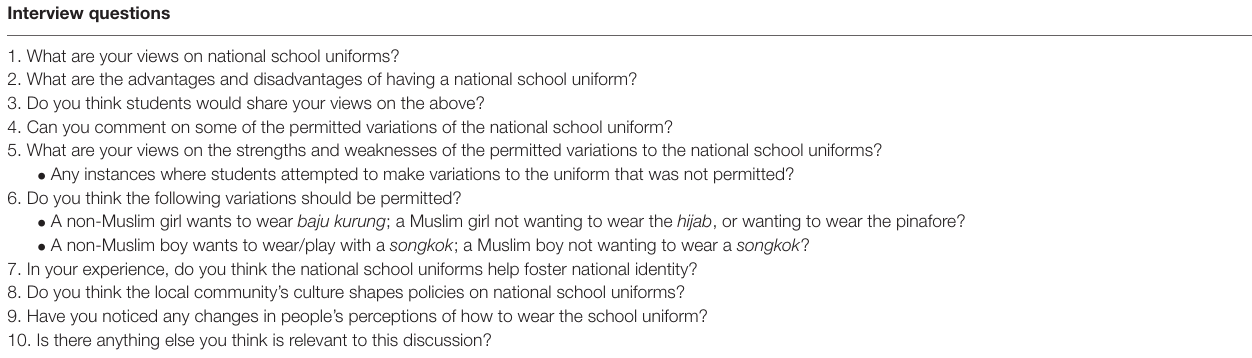
TABLE 3 | Interview questions for teachers and school